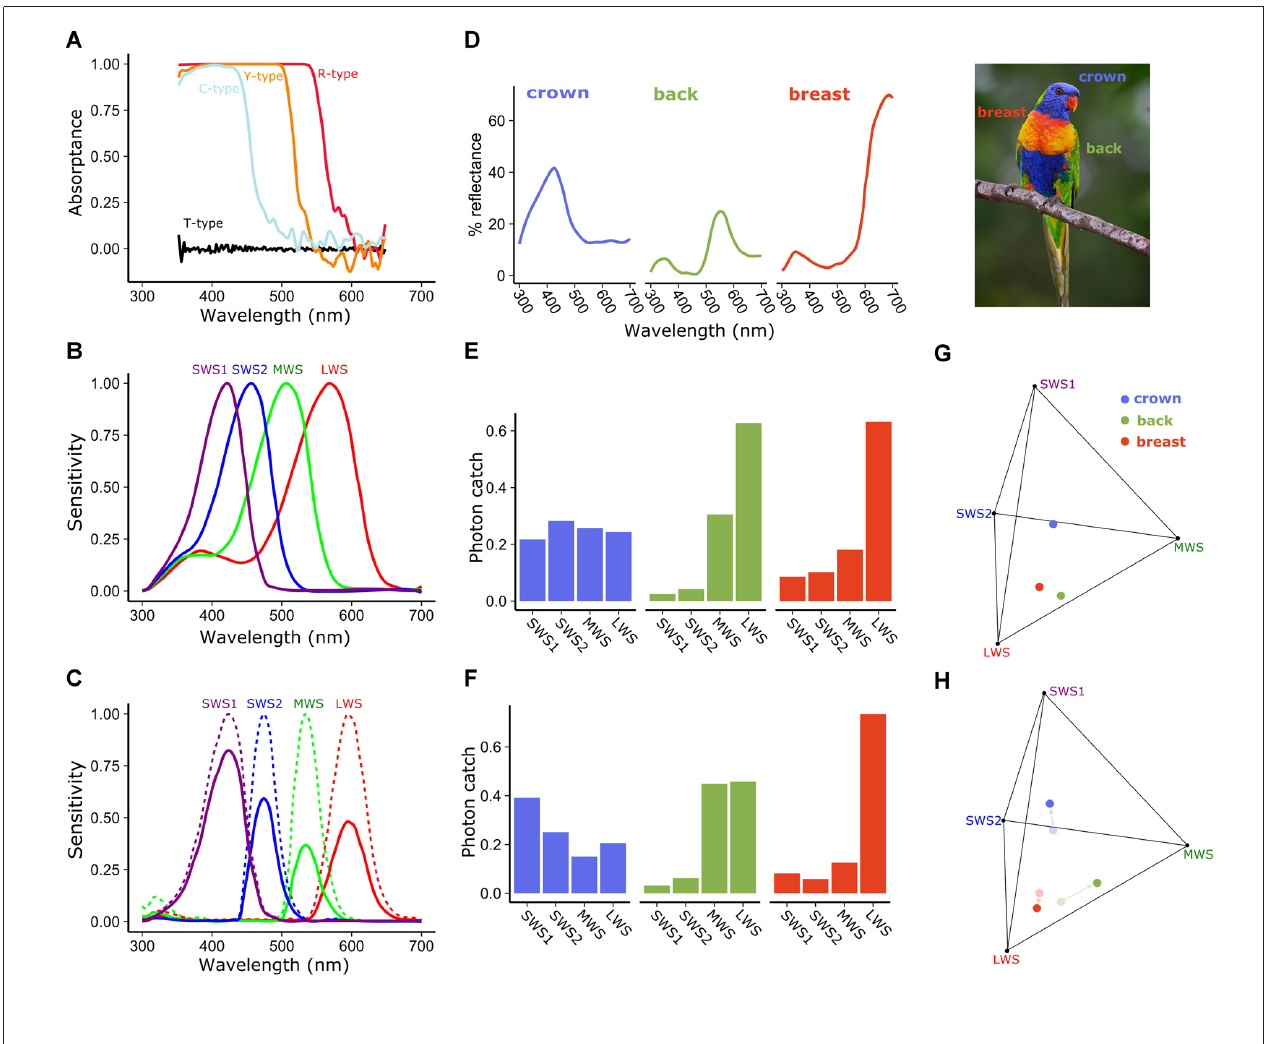
FIGURE 3 | Spectral filtering by cone oil droplets modifies receptor sensitivity and facilitates color discrimination. (A) The cone oil droplets of three of the four single cones of the chicken retina function as long-pass cut-off filters, absorbing nearly all light below the cut-off wavelength. These absorptance spectra are calculated based on measures of expanded oil droplets and estimated optical density of the unexpanded oil droplets. Note that the fine structure of the carotenoid spectra seen in Figure 2 are obscured by the high pigment concentrations in the unexpanded droplet spectra shown here. (B) The normalized spectral sensitivities of the opsins of the four single cones of the chicken retina without cone oil droplet filtering are relatively broad and overlapping. (C) Subtracting light absorbance and scattering by the oil droplets (as shown in A ) from the opsin sensitivities (shown in B ) results in substantially narrowed and reduced spectral sensitivities of cone photoreceptors. Solid lines represent the sensitivity spectra of the droplet-filtered cones, and the dotted lines are these same spectra normalized to their peak sensitivity. To illustrate the influence of this spectral filtering on color discrimination we calculated the photon catch of photoreceptors viewing the colored plumage patches (D) of the rainbow lorikeet ( Trichoglossus moluccanus ) and projected these onto the tetrahedral color space defined by the receptor sensitivities. Within this color space the distance among points is indicative of their discriminability. Points that are farther apart should be more readily distinguished (Vorobyev et al., 1998; Vorobyev, 2003). We calculated the proportional photon catch of each cone photoreceptor and color space location of these patches for a hypothetical visual system with (C,F,H) or without (B,E,G) cone oil droplets. The addition of cone oil droplet filtering changes the photon catch of the receptors and shifts the patches toward the vertices of color space. These changes are predicted to increase the volume of color space occupied by the Lorikeet’s plumage patches 37.1% as estimated by the convex hull method of Stoddard and Prum (2008). Lorikeet spectra were adapted from Dalrymple et al. (2015) and cone spectral sensitivities from Wilby et al. (2015). Photo credit: